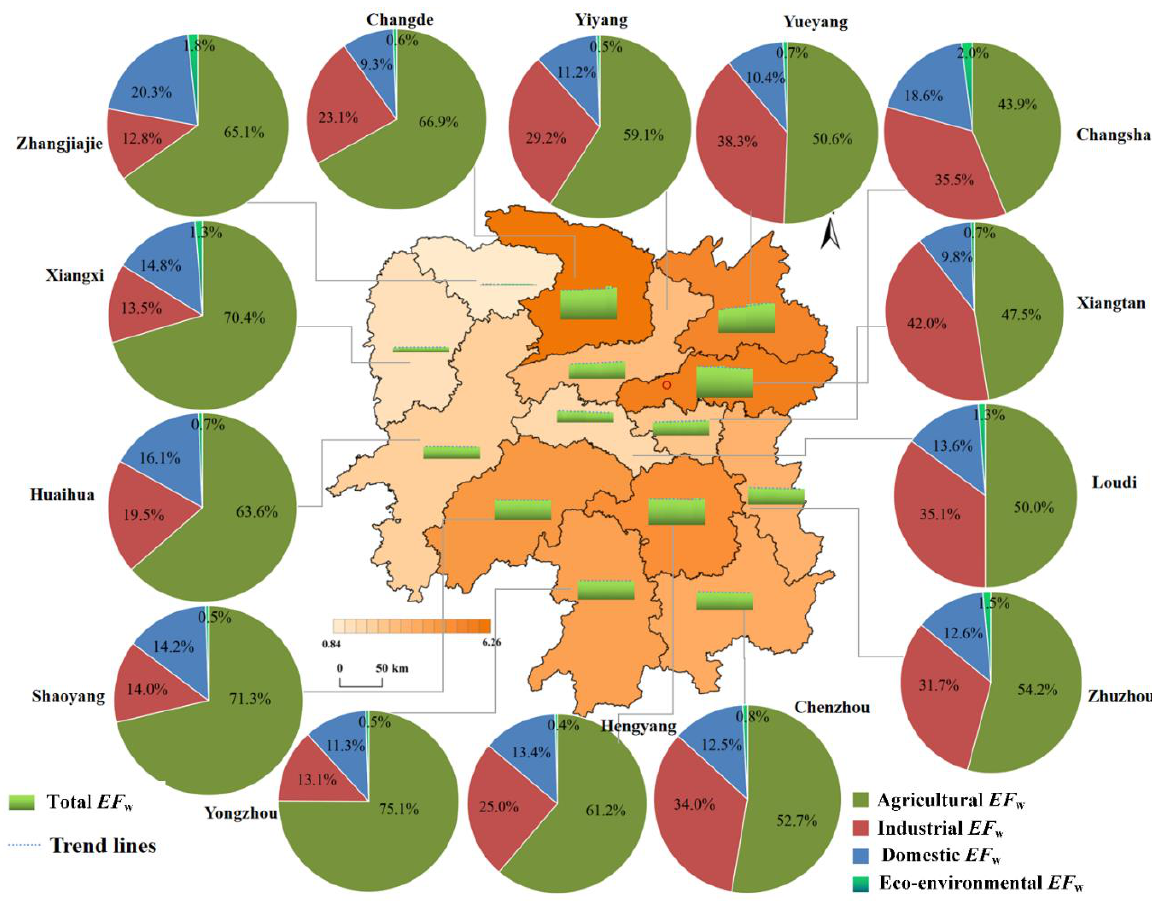
Figure 4. Spatial distribution of average annual evapotranspiration (ET) based on the data from 2010 to 2019 in Hunan Province ( a ), and its trend during this period ( b ).